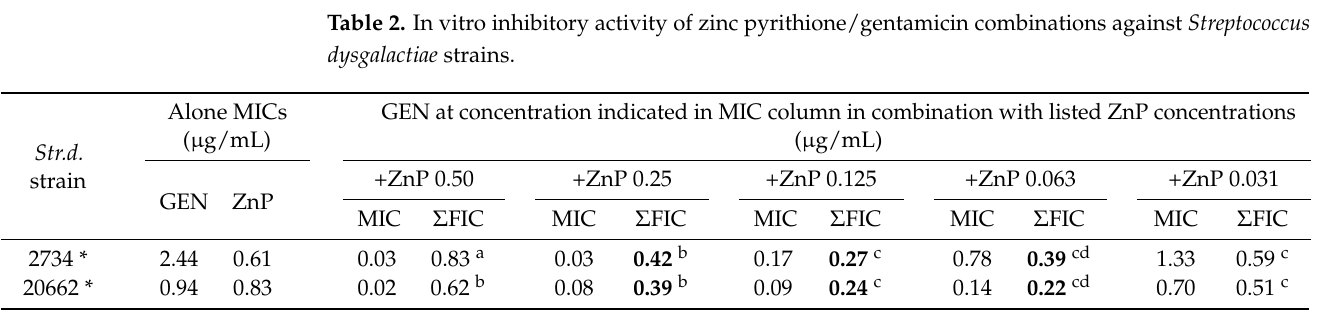
Table 2. In vitro inhibitory activity of zinc pyrithione/gentamicin combinations against Streptococcus dysgalactiae